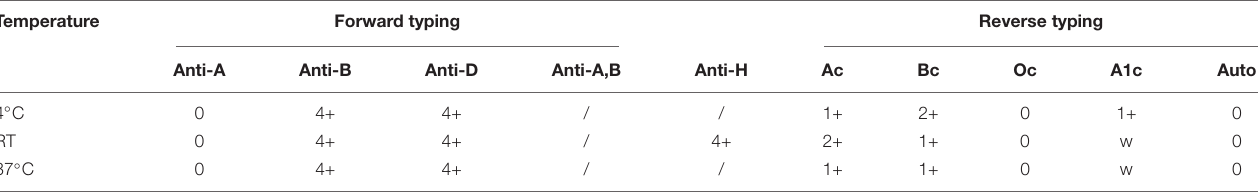
TABLE 1 | Serological results of the proband at different temperatures.